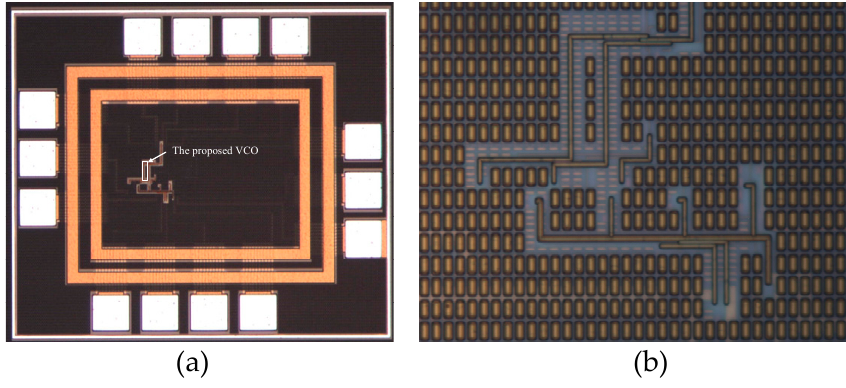
Figure 7. ( a ) Die photo of the whole chip; ( b ) Die photo of proposed VCO.